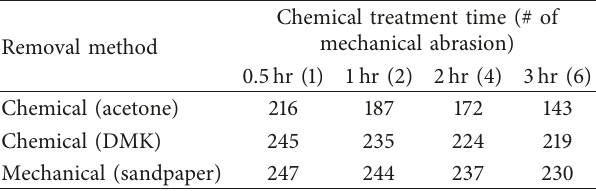
Table 4: POF diameters after clad removal (unit: µ m). Removal